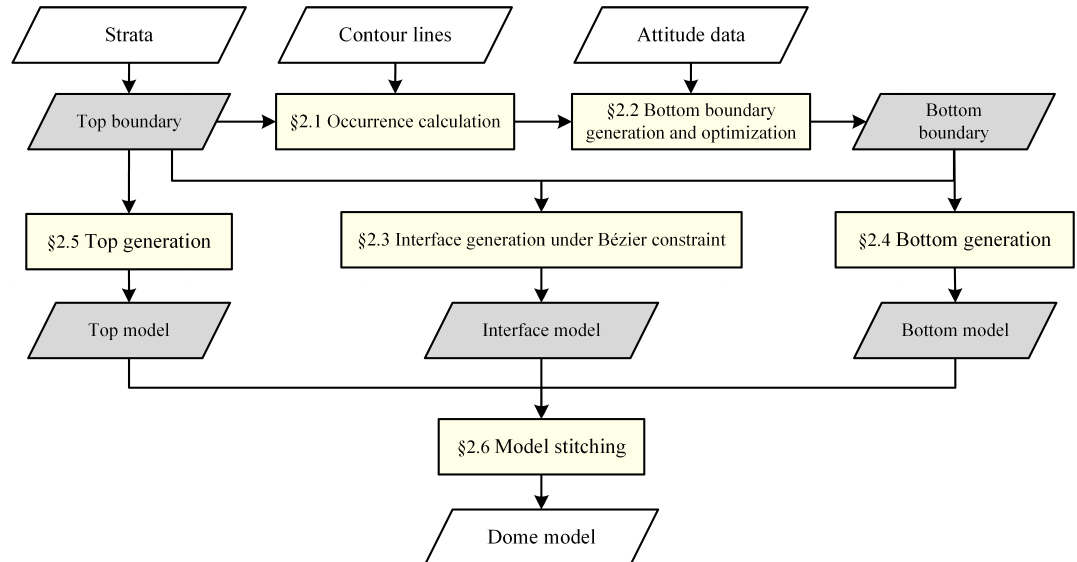
Figure 1. Construction process of dome structure models based on geological map. Among them, the yellow blocks represent the important steps in the modeling method described in detail in subsections